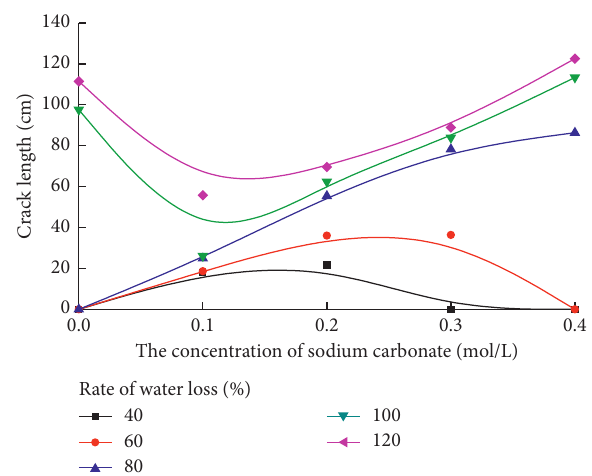
Figure 10: Relationship between the sodium carbonate concen- tration and the total length of the cracks.